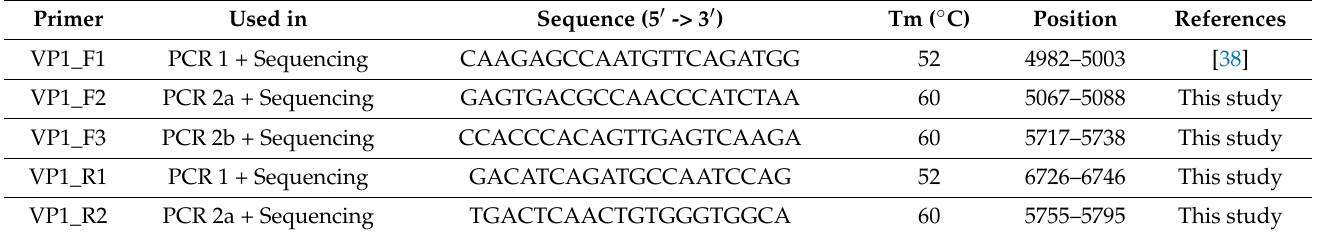
Table 2. Primer sequences used for PCR reactions and Sanger sequencing of the complete VP1 gene. Positions mapped in GII.4 genome (accession number KM198570). Tm indicates the annealing temperature used in the present